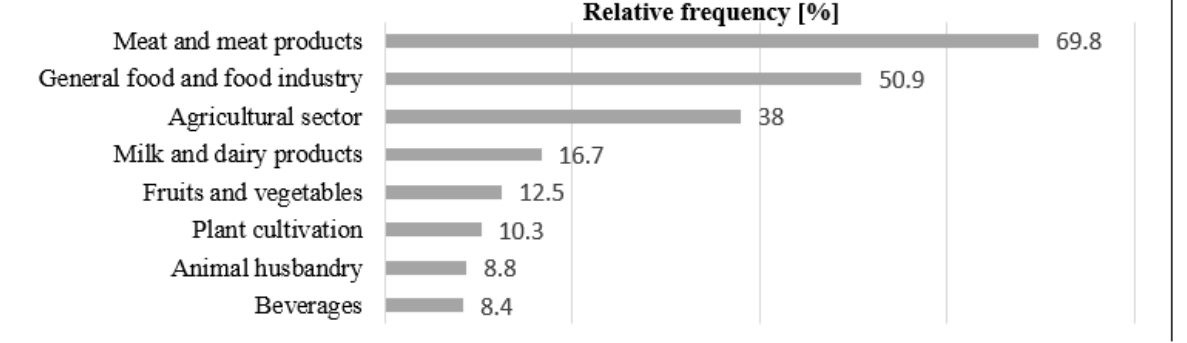
Figure 3. Relative frequencies of printed articles with a specific industry reference. Source: own calculations.